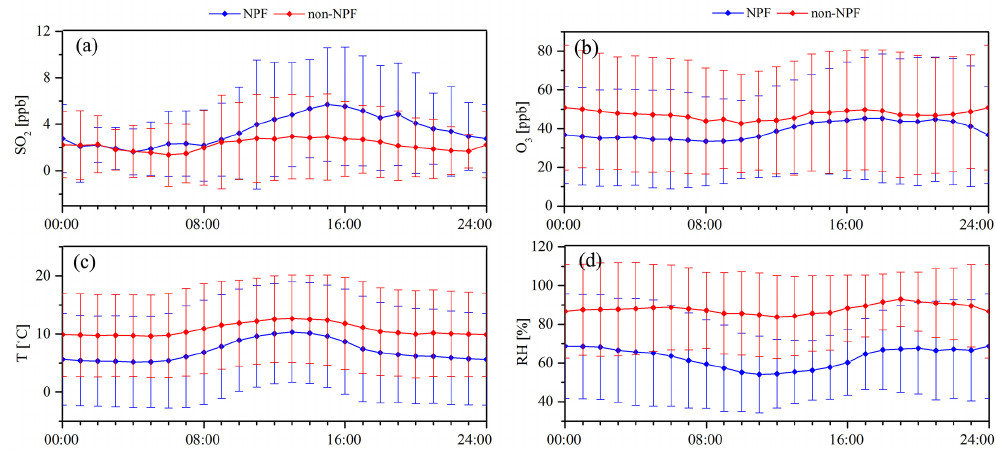
Figure 2. Average diurnal variations in trace gases (SO 2 and O 3 ) and meteorological conditions ( T and RH) on NPF days and non-NPF days over all campaigns at the summit of Mt. Tai.